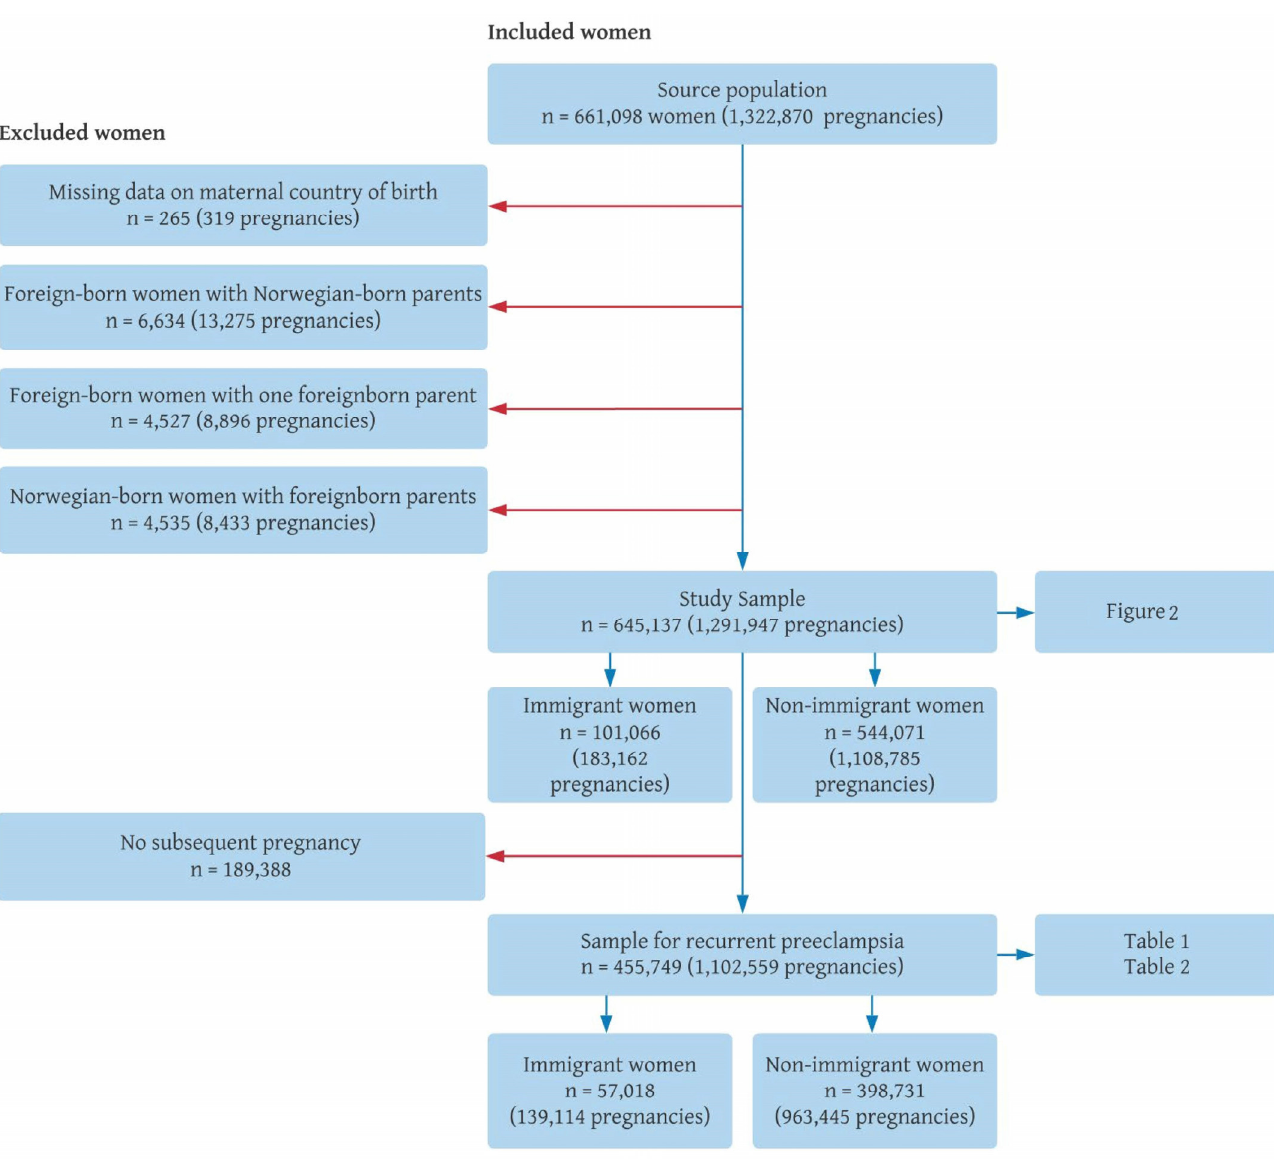
Figure 1. Derivation of the study sample, Norway, 1990–2016.